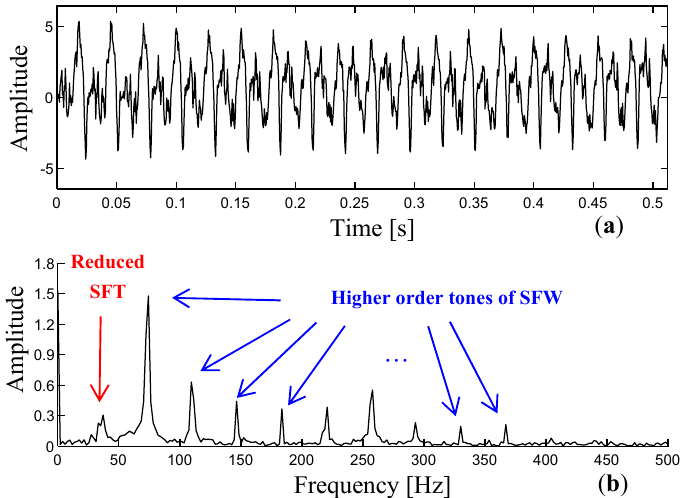
Figure 19. The time domain waveform ( a ) and the FFT spectrum ( b ) of the displacement signal after reduction of strong sinusoidal wave.